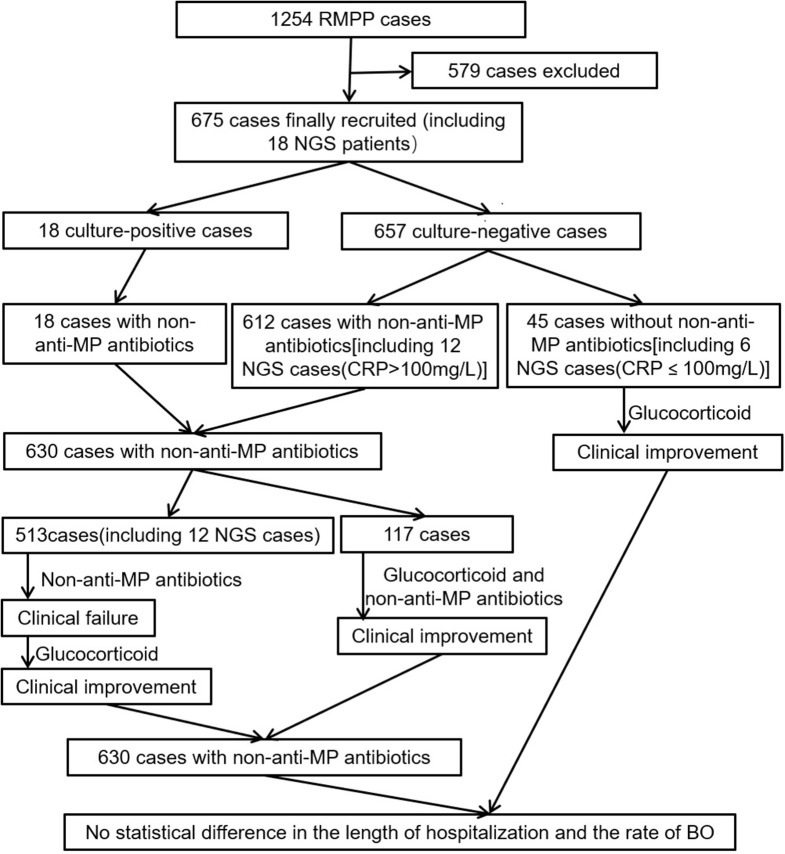
Flow diagram of patient enrollment and treatment.